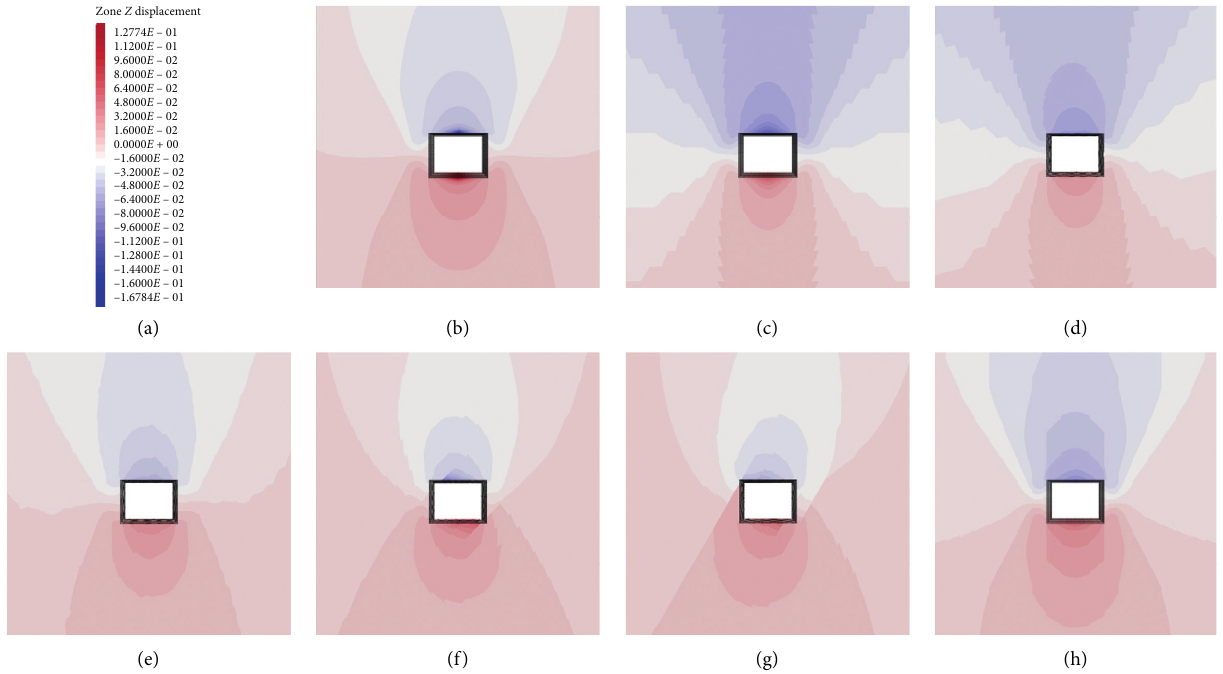
Figure 7: Vertical displacement nephogram. (a) Displacement legend. (b) No structural plane. (c) Horizontal structural plane. (d) Structural plane with 15 ° . (e) Structural plane with 30 ° . (f) Structural plane with 45 ° . (g) Structural plane with 60 ° . (h) Vertical structural